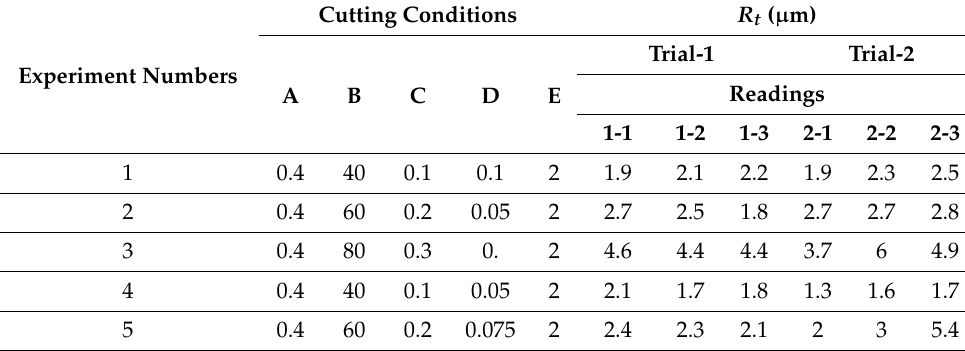
Table 7. Experimental results regarding surface roughness ( Rt